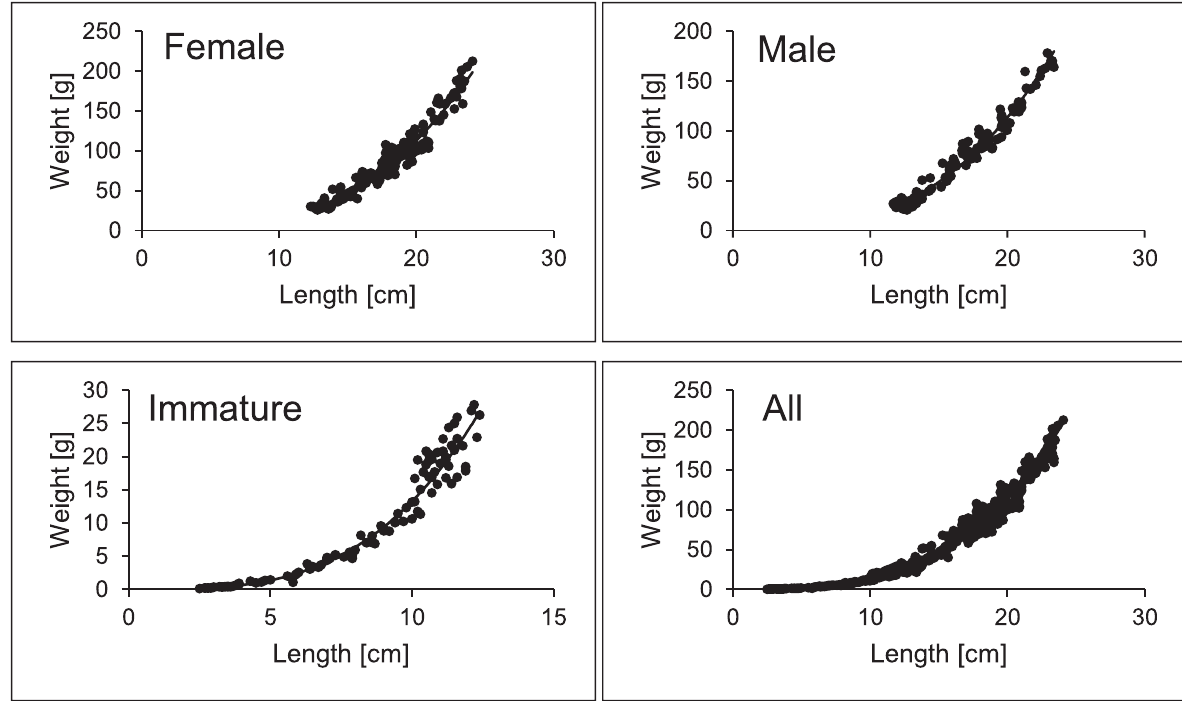
Fig. 3. Length-weight relations of female, male, immature and all sand steenbras from Köyceğiz Lagoon